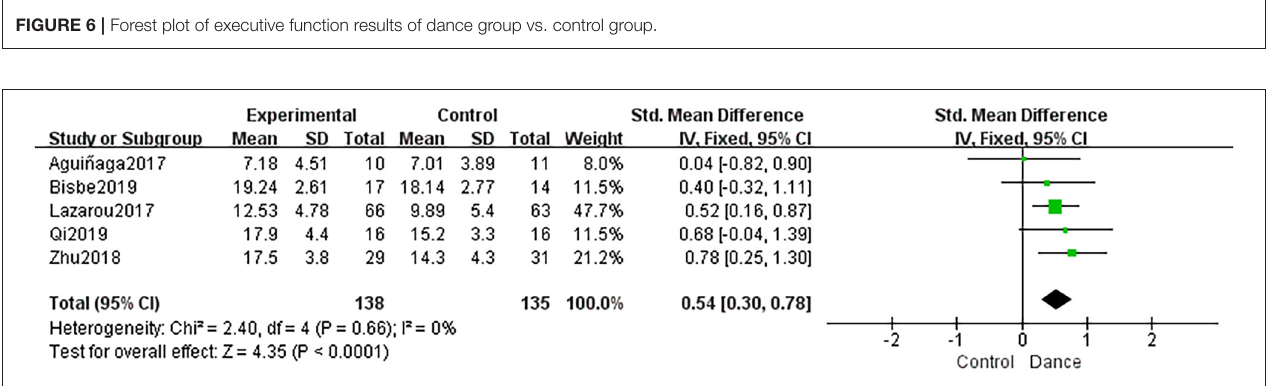
FIGURE 7 | Forest plot of immediate recall results of dance group vs. control group.